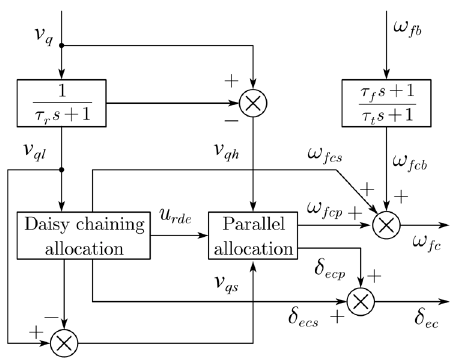
Figure 15. Pitch channel control allocation.